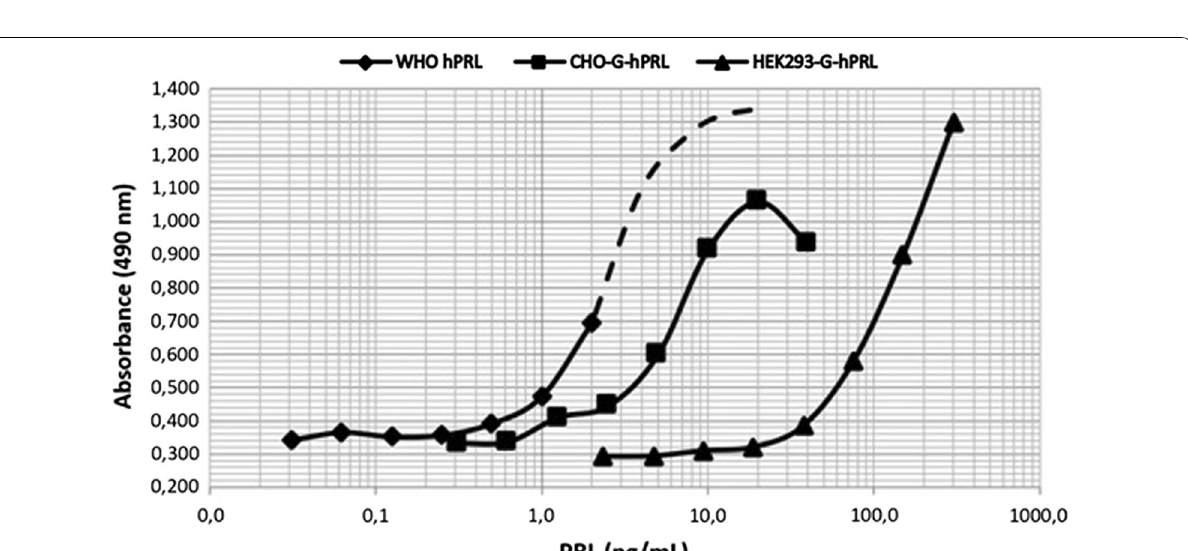
Fig. 5 Bioactivity determination of G-hPRL of different origins via the BaF/3-LLP in vitro bioassay: relative potencies have been determined by comparing the ED 50 of the different curves and considering the nominal activity of 57.2 IU/mg for the International Standard of hPRL (WHO